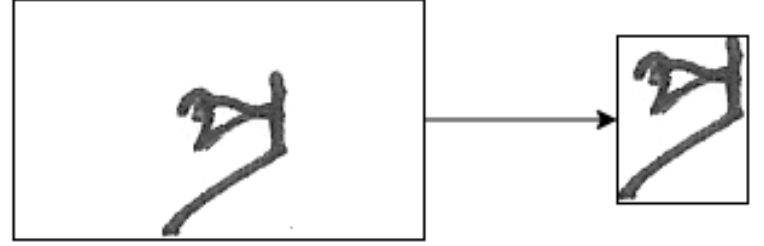
Figure 5. Example of auto-cropping on a sample